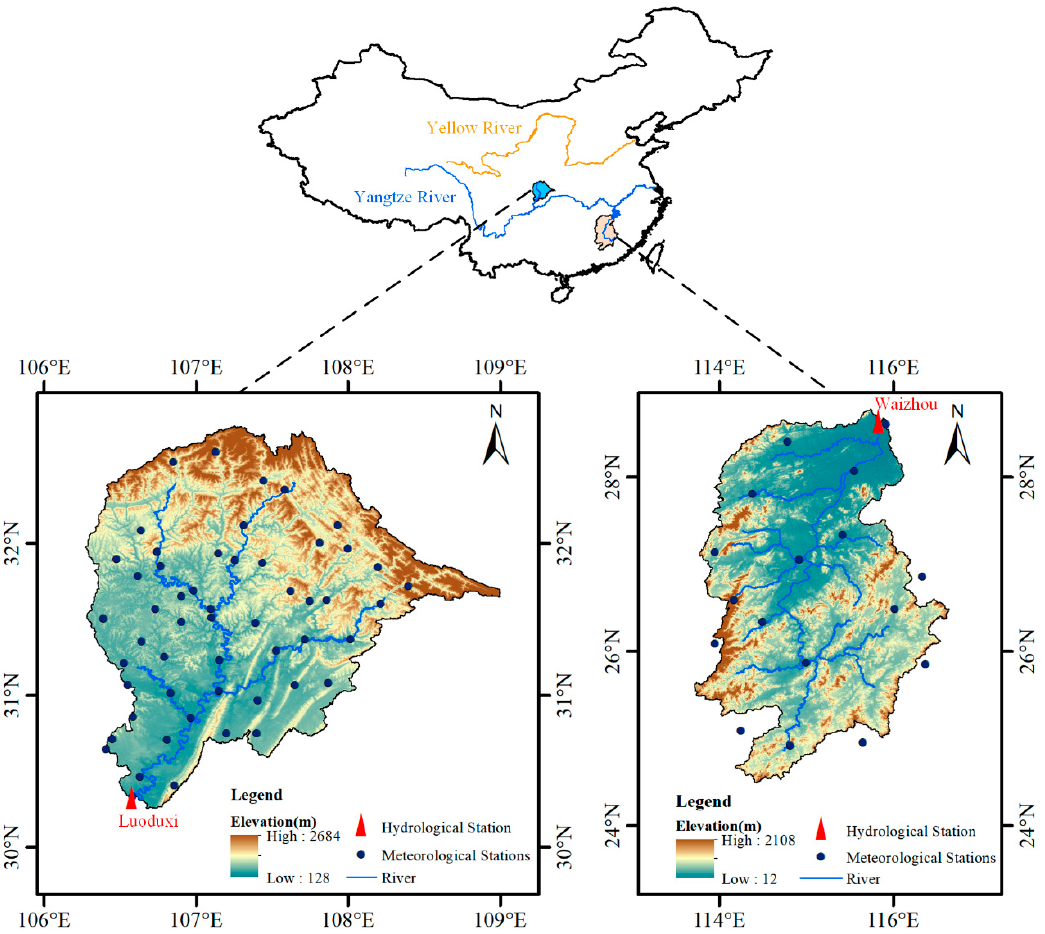
Figure 1. Location of the Qujiang basin (QJ) and the Ganjiang basin (GJ) and their corresponding meteorological stations (blue dots) and hydrological station (red triangle).